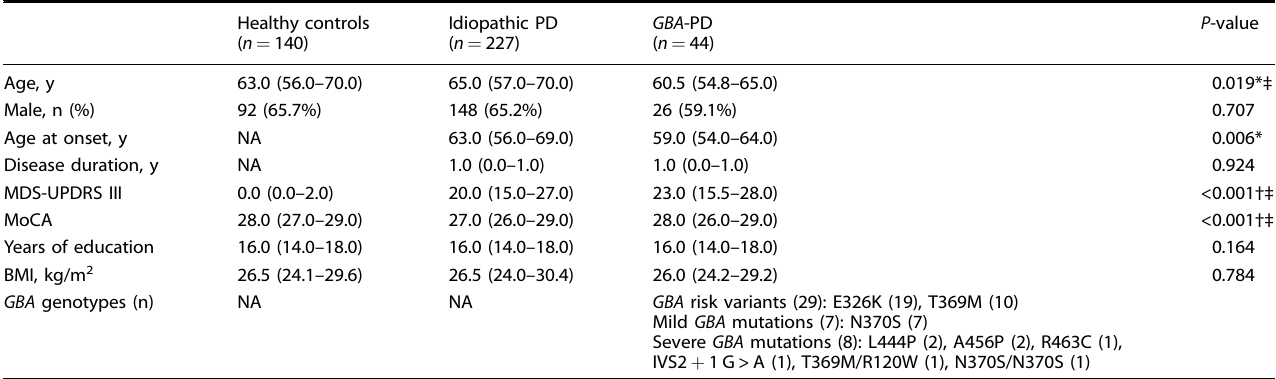
Table 1. Clinical characteristics and GBA genotypes of participants from the Parkinson ’ s Progression Markers Initiative ( n = 411). Healthy controls ( n =